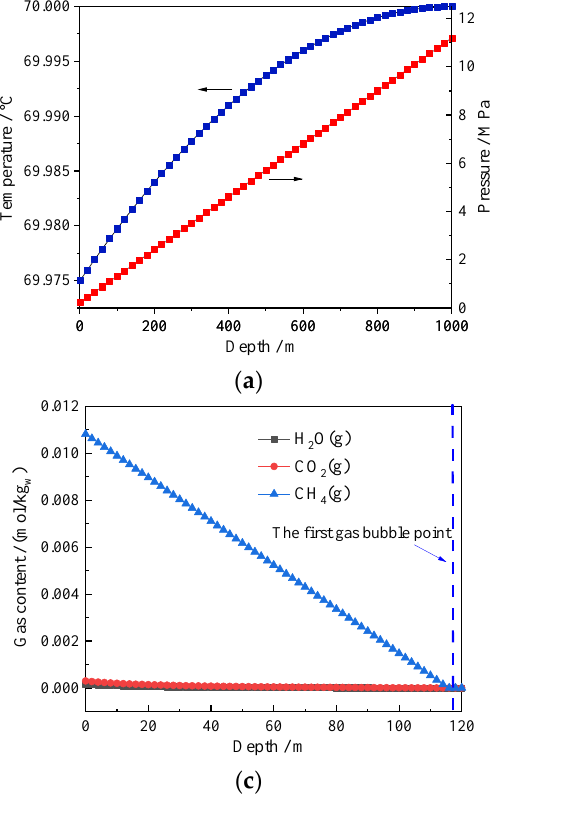
example. The final amount of scale is calculated by keeping CaCO 3 saturation index less than zero. As can be seen from the figure, under a well bottom temperature of 70 ◦ C, the reaches a certain level, the amount of scale approaches 0. Under the same CO 2